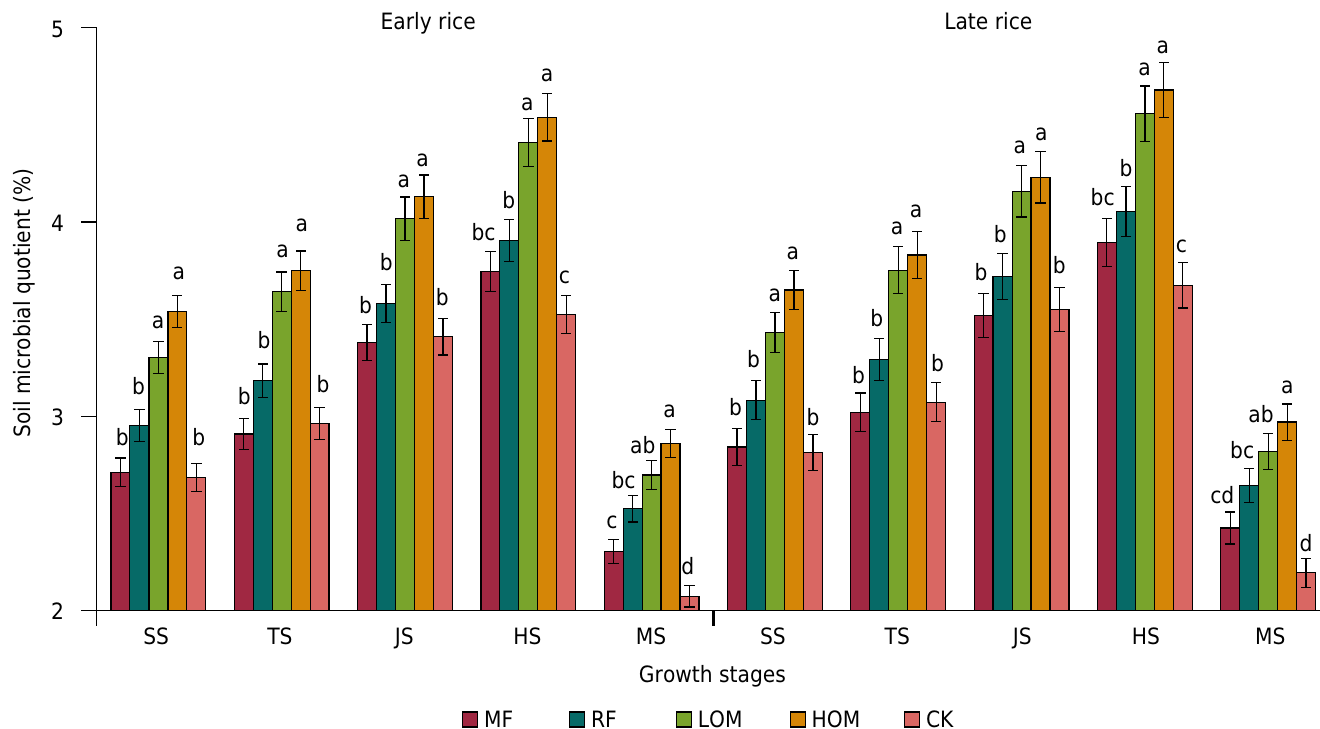
Figure 5. Effects of different long-term fertilization treatments on soil microbial quotient in a paddy field at main rice growth stages. MF = mineral fertilizer alone; RF = rice straw residues and mineral fertilizer; LOM = 30 % organic matter and 70 % mineral fertilizer; HOM = 60 % organic matter and 40 % mineral fertilizer; CK = without fertilizer input; SS = seedling stage; TS = tillering stage; JS = jointing stage; HS = heading stage; MS = mature stage. Bars represent standard deviation (SD) of three replicates. Different letters indicate significance at p < 0.05 among the fertilization treatments at the same rice growth stage, according to the least significant difference test.